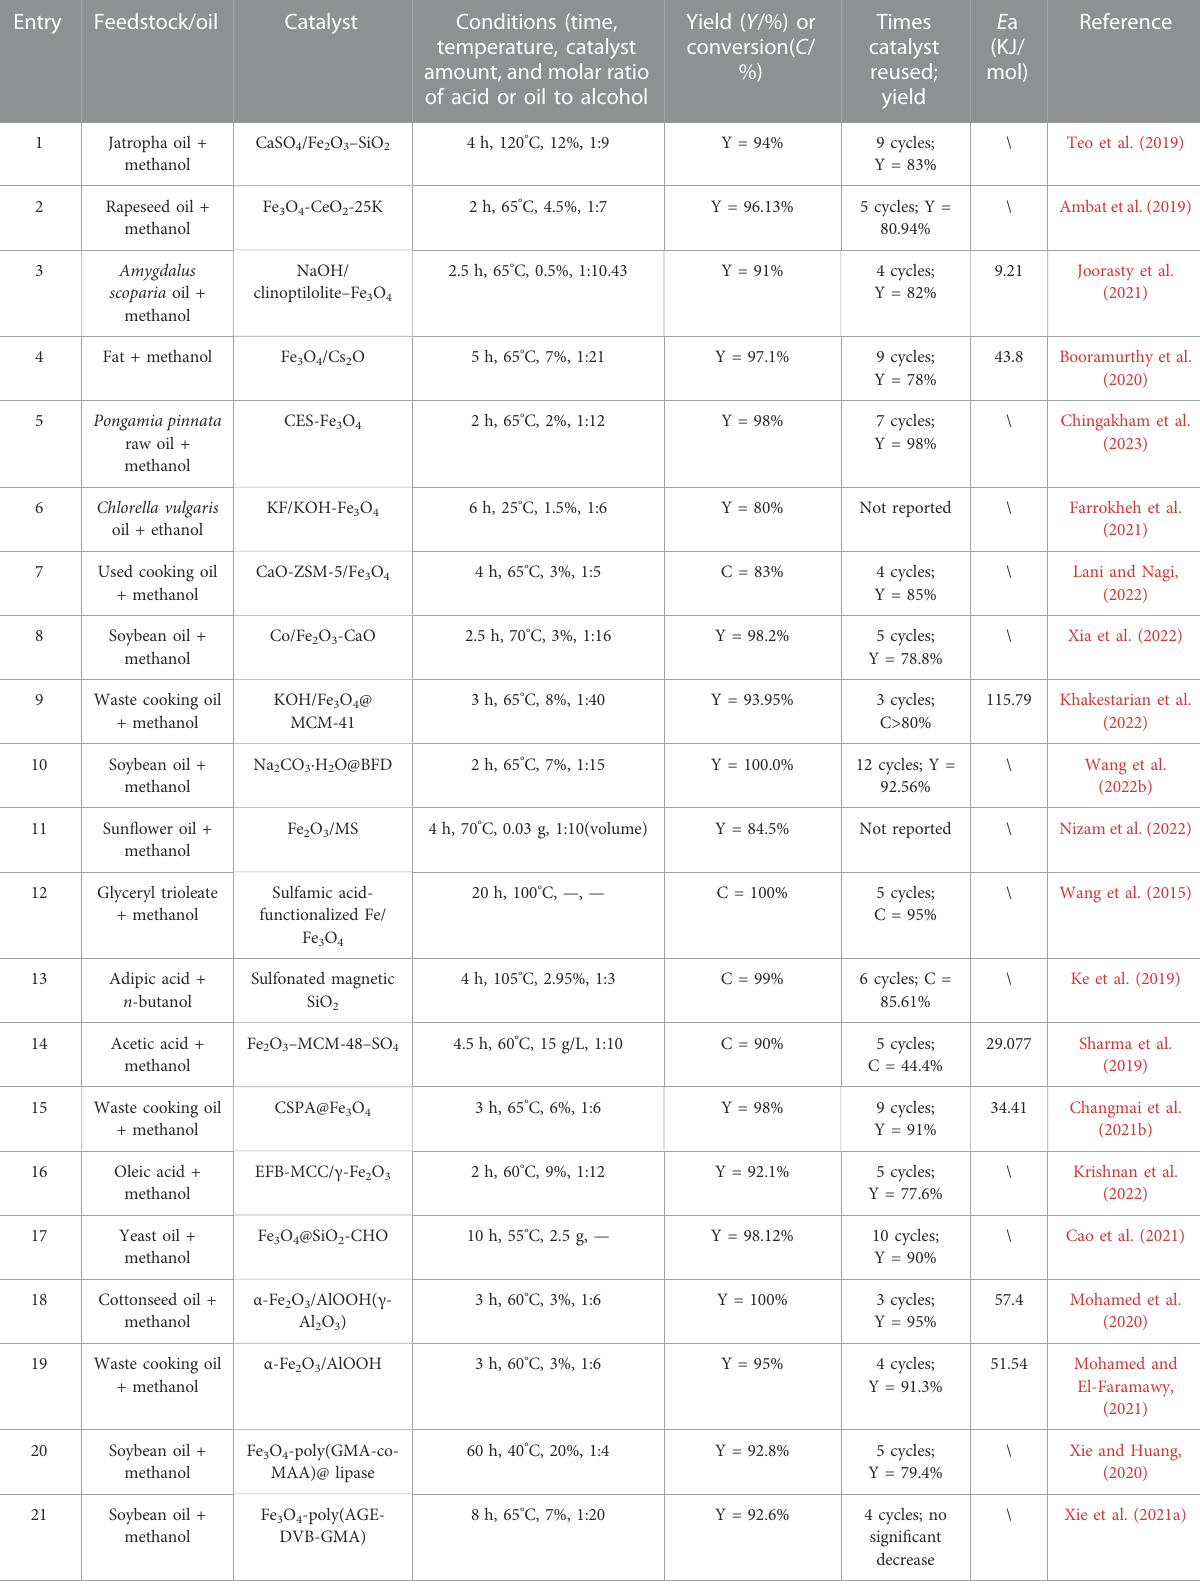
TABLE 1 Recent fi ndings on green biodiesel production using supported magnetic